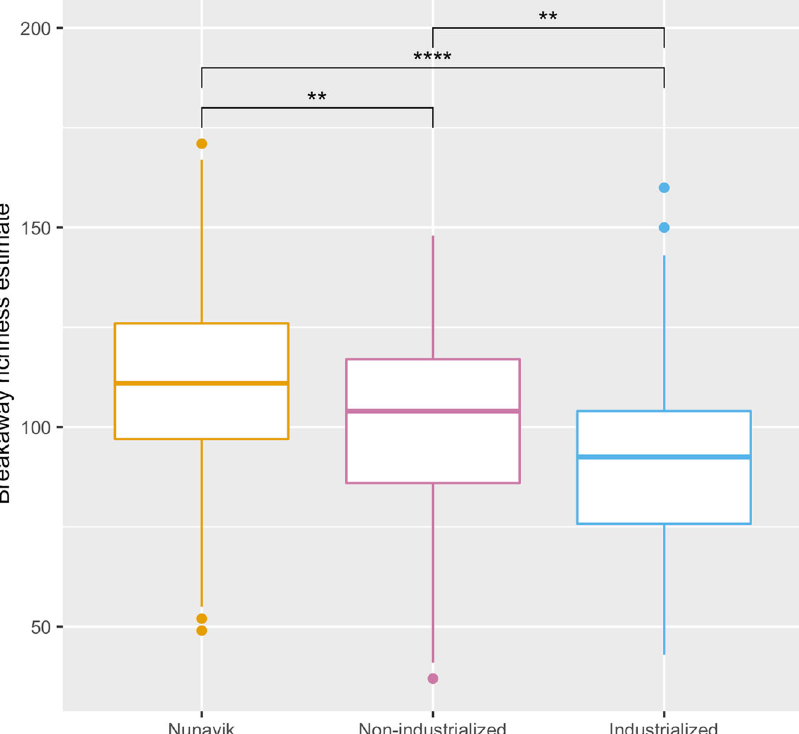
Fig. 1 Measure of intra-individual diversity at species level of the microbiome in Nunavik Inuit, in individuals from non-industrial and industrial societies. Breakaway richness estimate highlights a higher alpha diversity in the Nunavik gut microbiome ( n = 279), compared to non-industrial ( n = 73, T-test; p -value = 0.005) and industrial ( n = 104, T-test; p -value = 7.6e-14) populations. (* p -value ≤ 0.05, ** p -value ≤ 0.01, *** p -value ≤ 0.001, **** p -value ≤